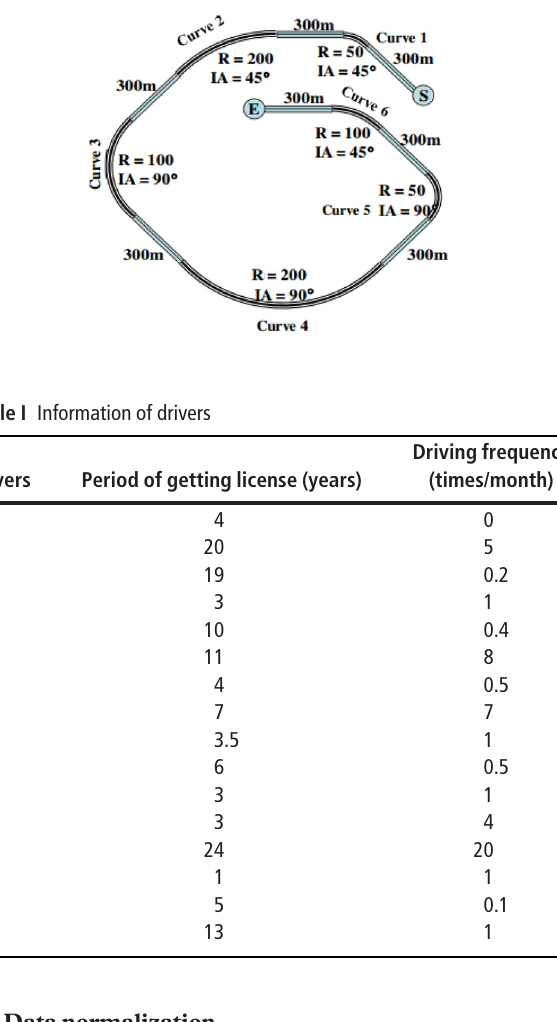
Figure 4 Driving route of experiments